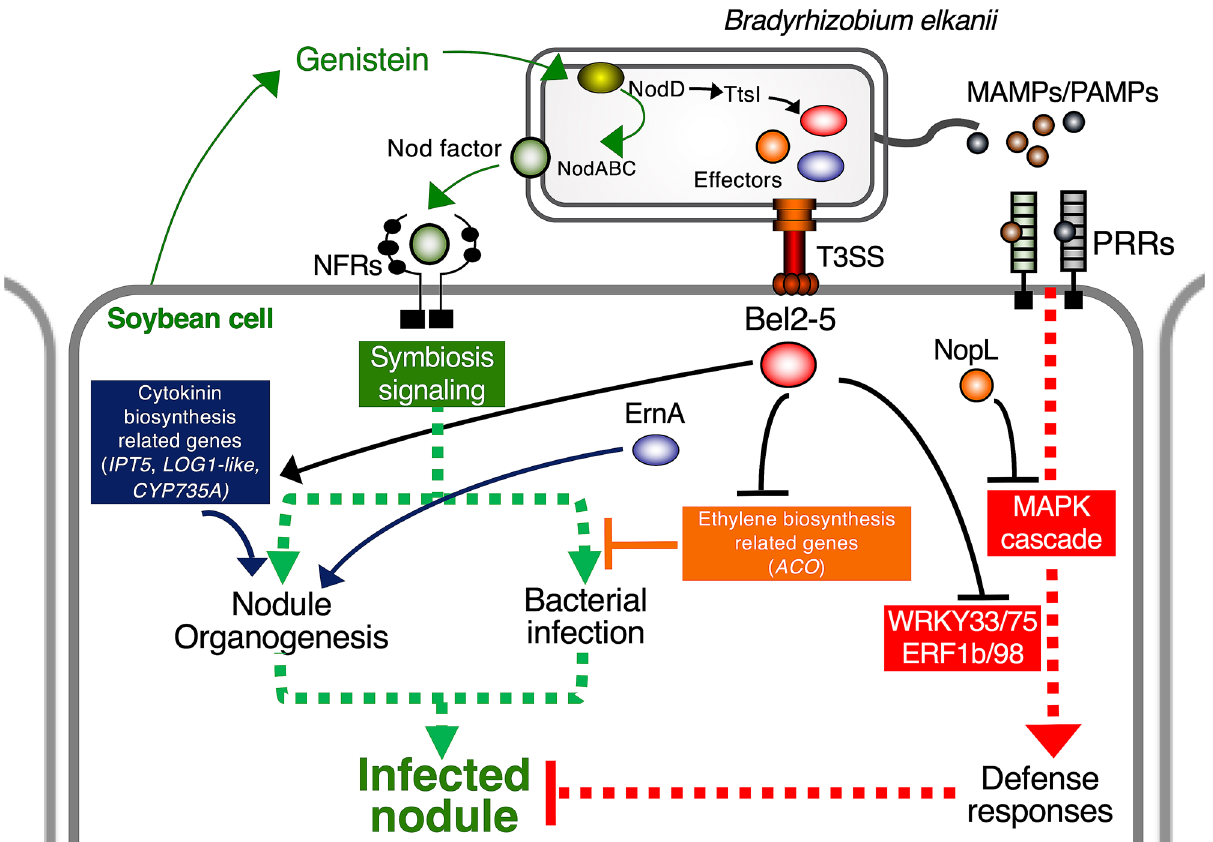
Figure 7. Proposed model for nodulation signaling and modulation by Bradryhizobium elkanii type III effector Bel2-5. A soybean root-derived genistein induces the production of Nod factors (NFs) in B. elkanii . Recognition of NFs by NF receptors triggers a signaling cascade leading to nodulation. The genistein also induces B. elkanii to inject effector proteins into soybean cells. NopL suppress plant defense responses by modulating the MAPK cascade. The ErnA effector triggers nodule organogenesis by a yet unknown mechanism. Bel2-5 effector likely interferes with the nodulation signaling pathway at least at two levels: (1) by modulating cytokinin biosynthesis- related genes that promoting nodule organogenesis and (2) by repressing ethylene biosynthesis-related genes and host-dependent defence responses that are deleterious to the bacterial infection. It should be noted that these DEGs may contain secondary and tertiary indirect effects as well as Bel2-5 direct